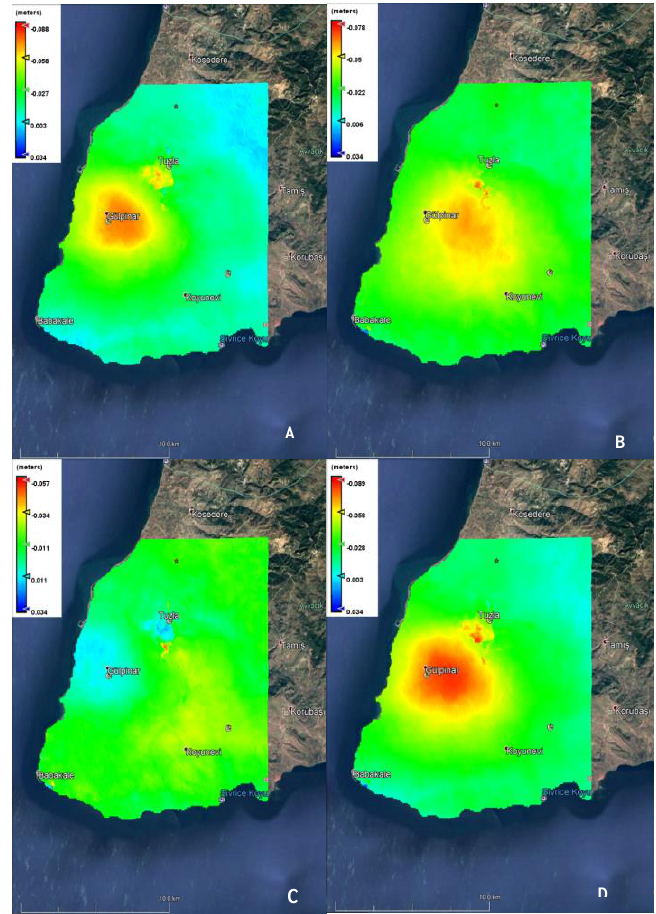
Figure 4. Sentinel-1 deformation results: a) ascending orbit, b) descending orbit, c) horizontal, d) vertical. (Background